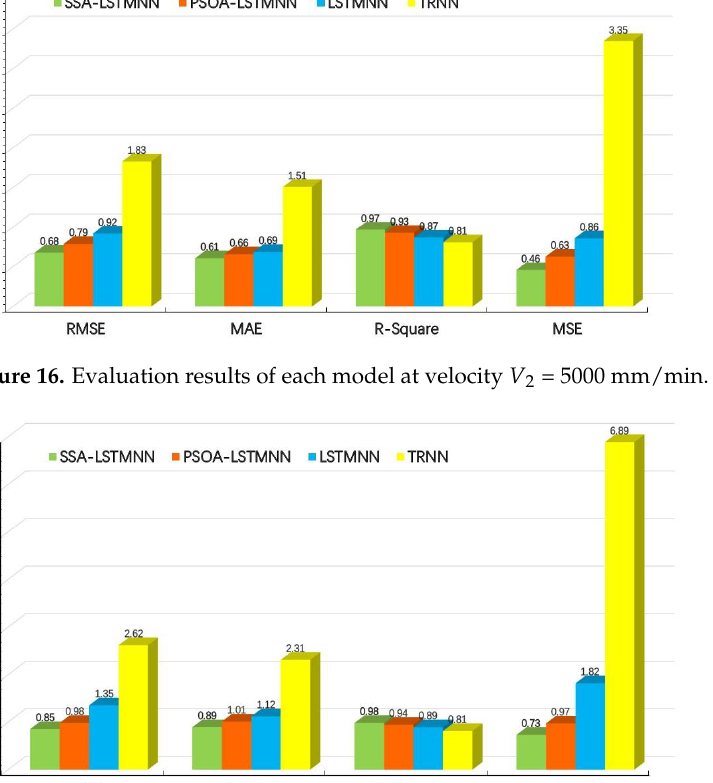
Figure 17. Evaluation results of each model at velocity V 3 = 8000 mm/min.